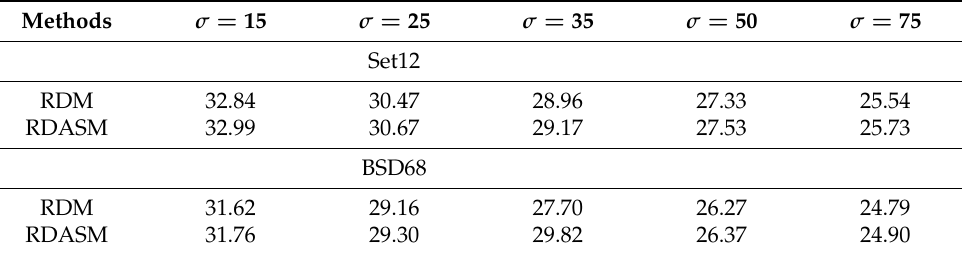
Table 6. PSNR (dB) of RDASM and RDM using the Set12 and BSD68 datasets for different noise levels (i.e., 15, 25, 35, 50, and 75).